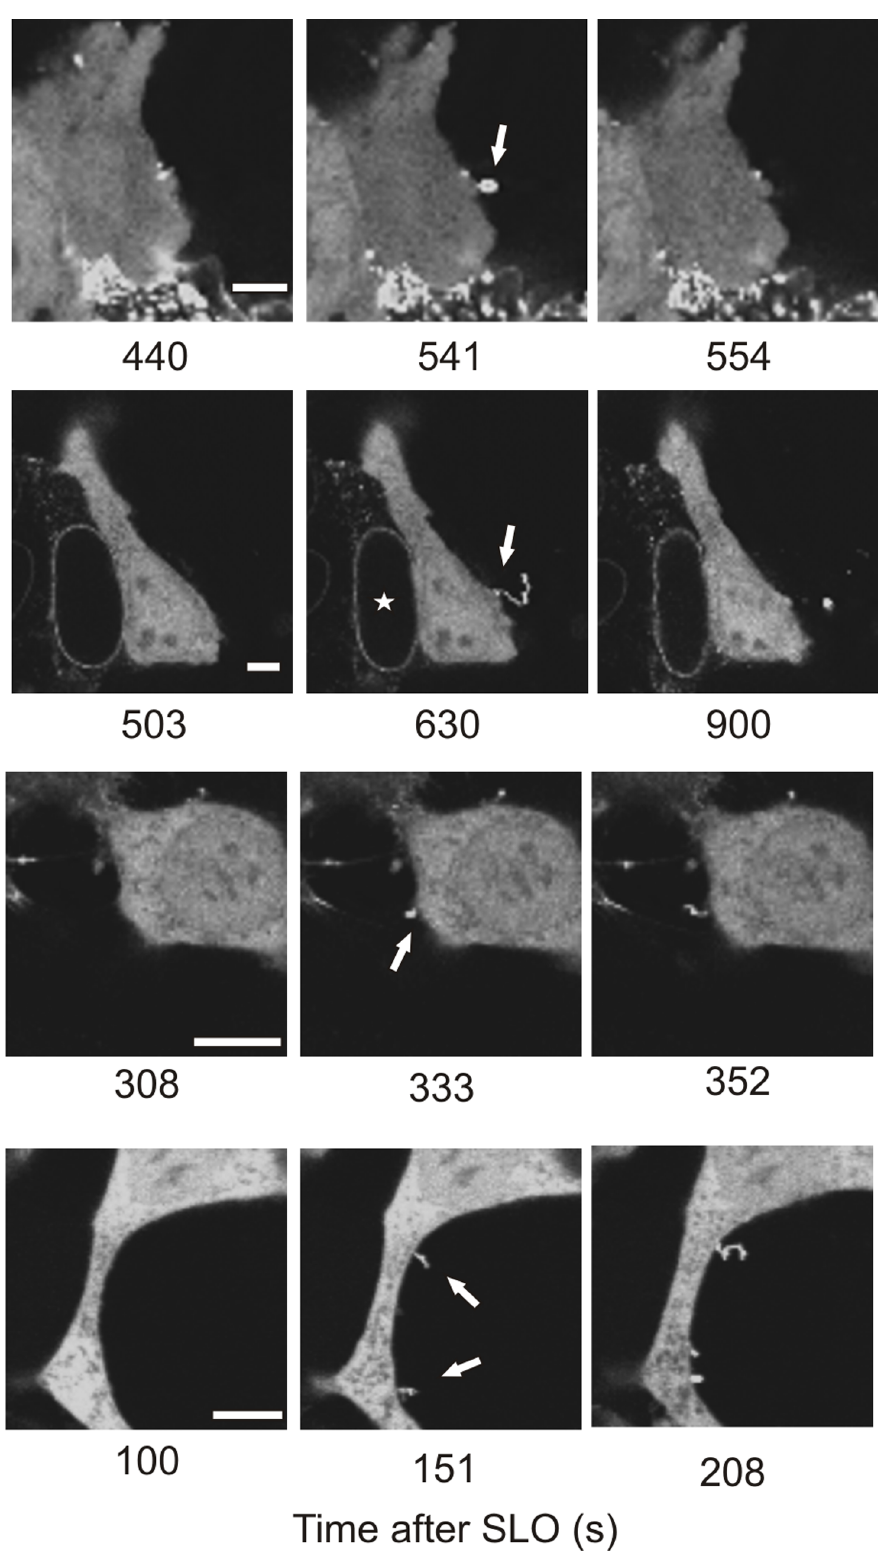
Figure 3. Pinpoint shedding of microvesicles. Two HEK 293 and two SH-SY5Y cells transfected with annexin A1-YFP are shown. SLO-pores are quarantined within compact plasmalemmal regions or within thin outward protrusions (arrows). An asterisk denotes the nucleus of a lysed cell. Magnification bars=5 m m.